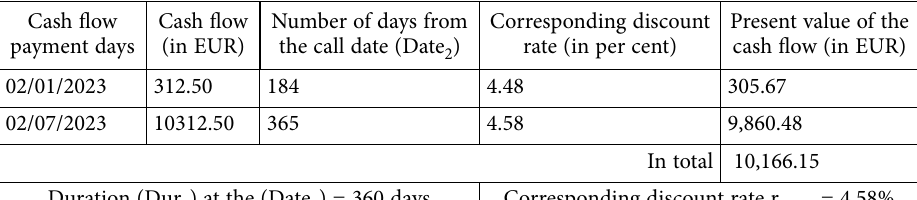
Table 2. Calculation of the discount rate r Dur2 at the call date (Date 2 –